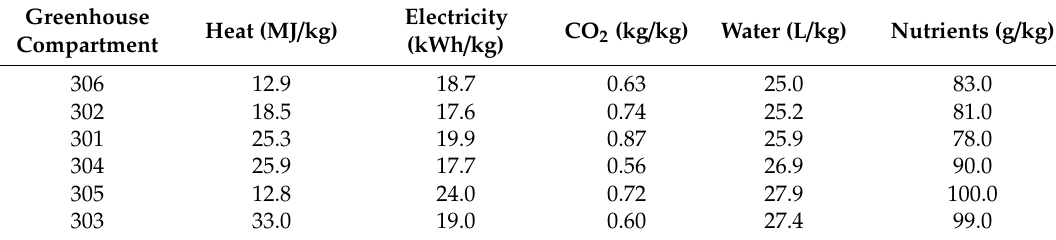
Table 2. Resource use e ffi ciency (unit resource used per kg tomato produced) for di ff erent teams and their crop in di ff erent greenhouse compartments during the experimental period, heat (MJ / kg),